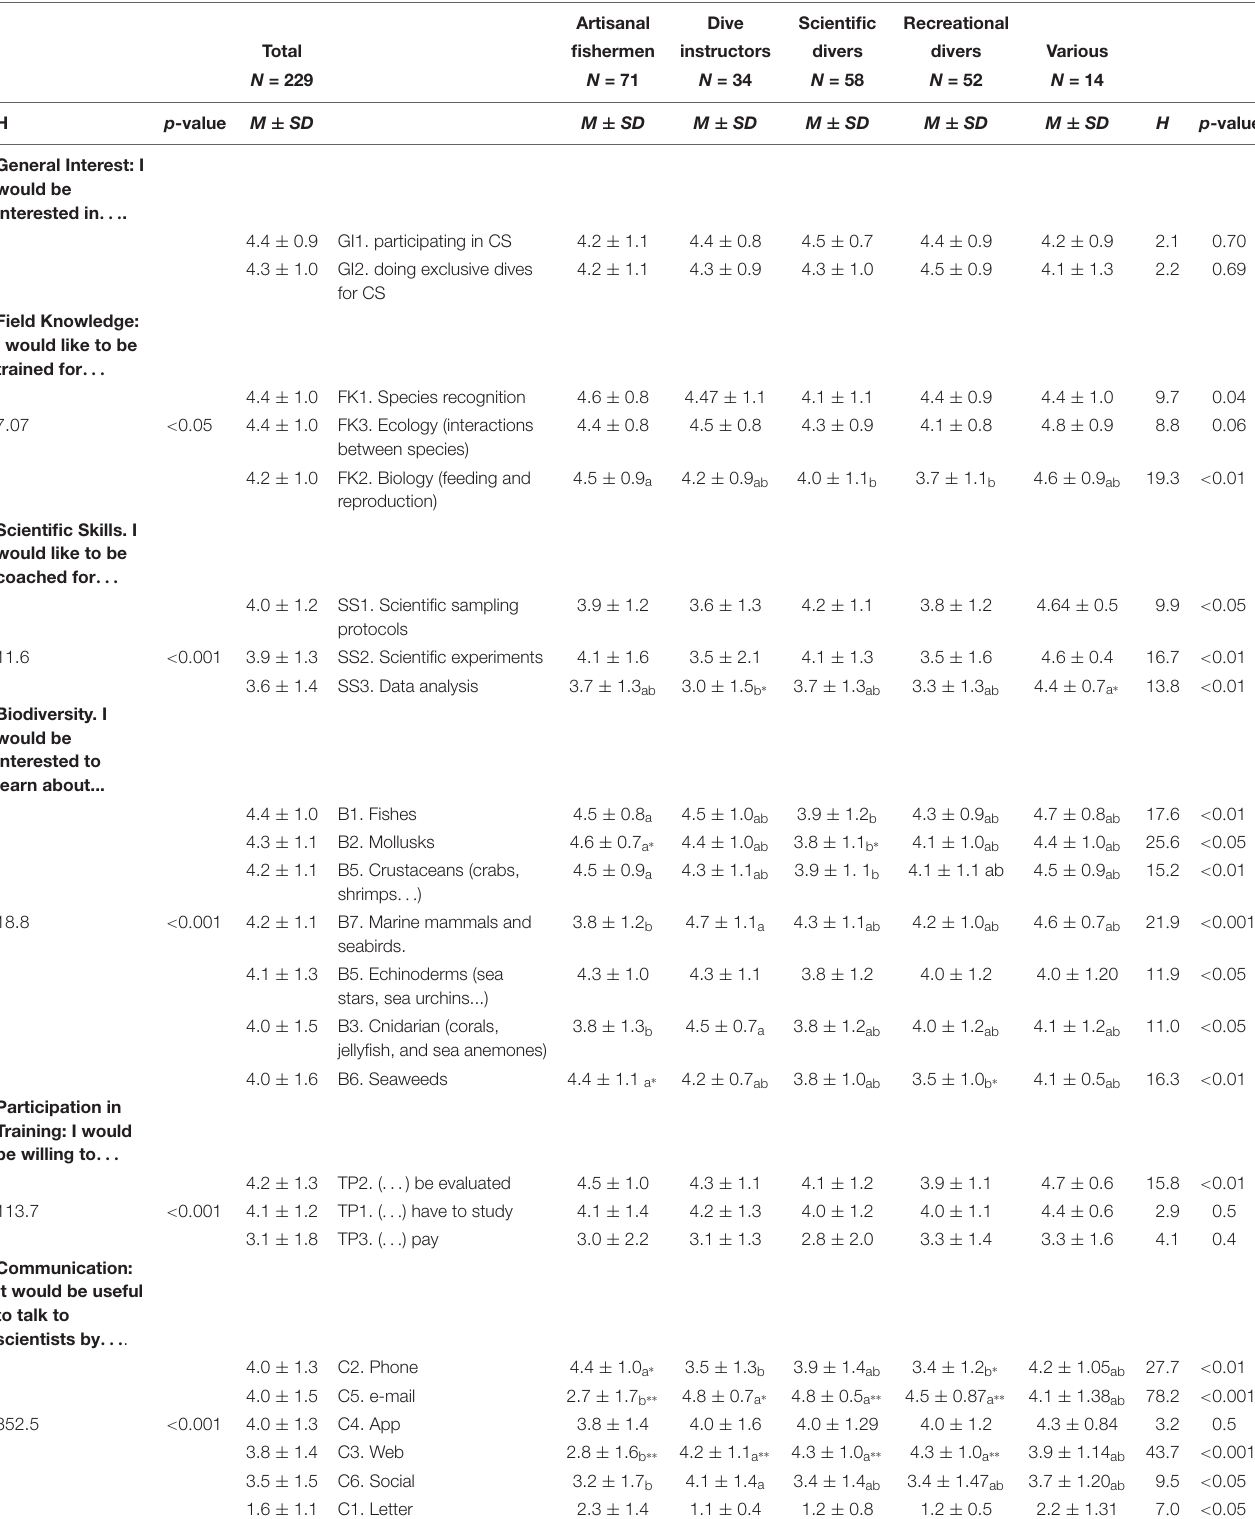
TABLE 4 | General interest and preferences in CS for each diver